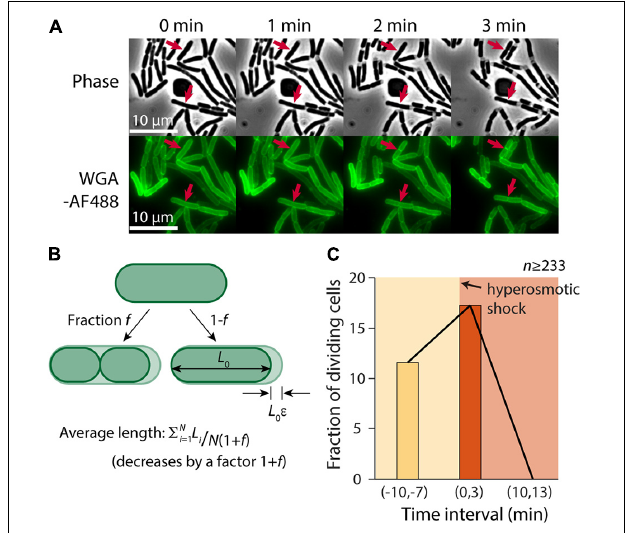
FIGURE 2 | A transient burst of cell division follows hyperosmotic shock. (A) In the 3 min after exposure to a hyperosmotic shock, a fraction of cells continued to divide (red arrows indicate a few examples) despite growth largely halting (Figure 1C). Shown is a time-lapse in phase contrast (top) and fluorescence of the wall label WGA-AF488 (bottom). (B) If a fraction f of cells divide during the interval between the hyperosmotic shock and imaging on an agarose pad, the average length of cells post-shock will decrease by a factor (1 + f ), leading to a predicted increase in the plasmolysis strain by (1 + f ).